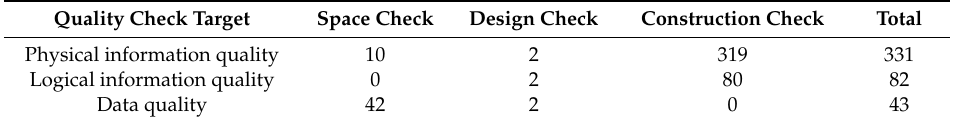
Table 16. The achievement score by quality check target.